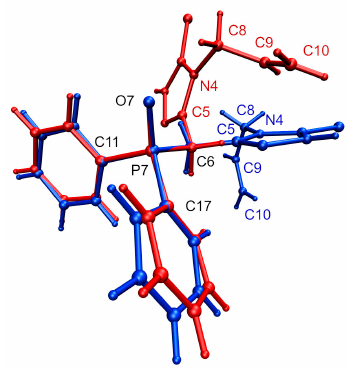
Figure 2. Overlay of molecules in polymorphs 1a (blue) and 1b (red), the atom P7 and four connected atoms are superimposed.